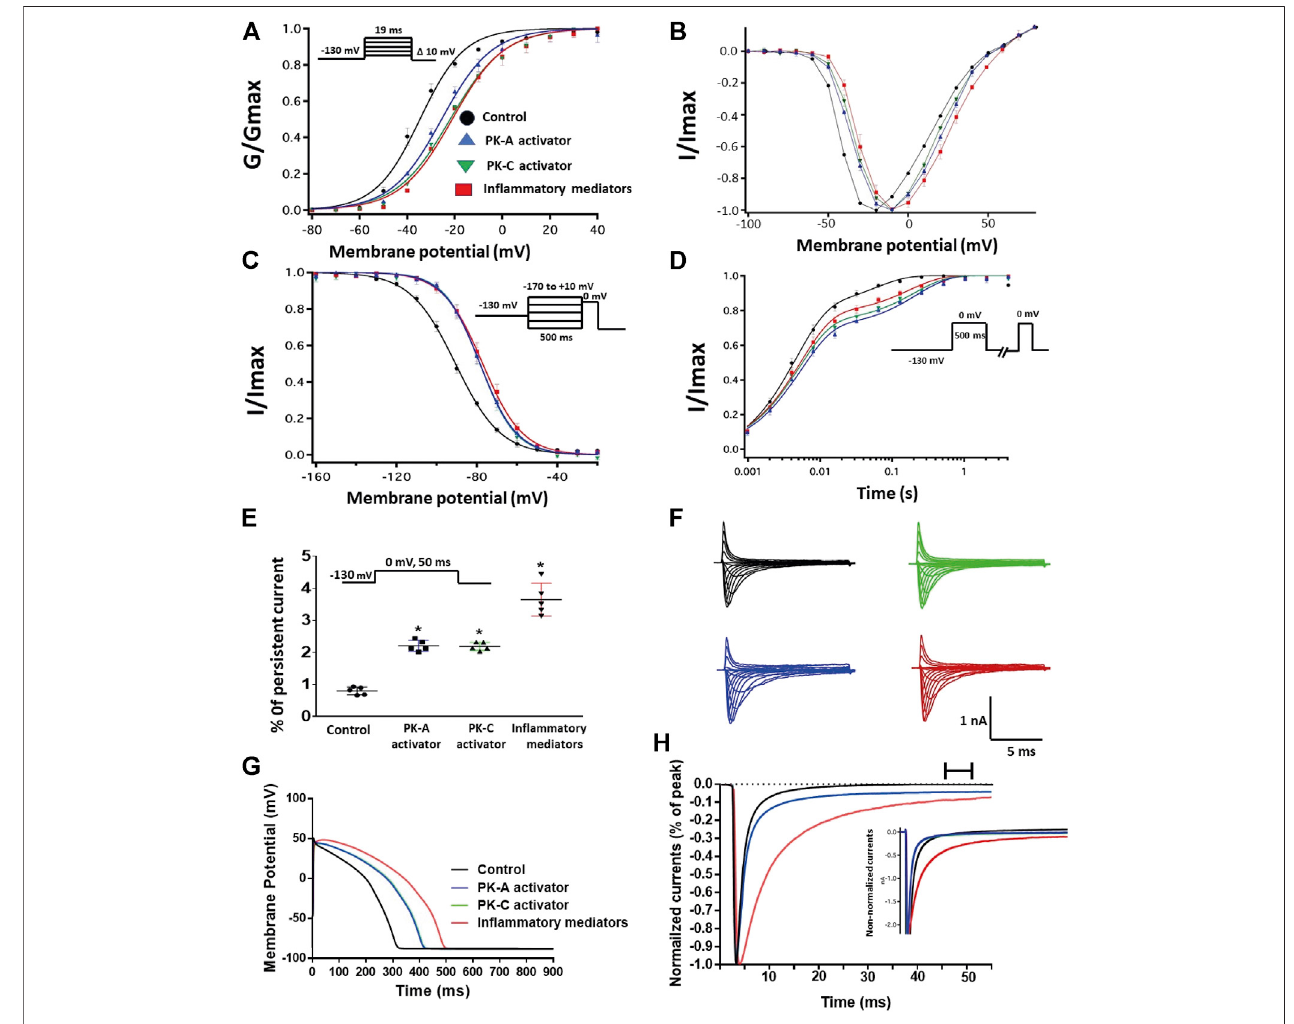
FIGURE 2 | (A) Effect of in fl ammatory mediators (for 24 h) or PK-A activator (CPT-cAMP; 1 μ M, for 20 min) or PK-C activator (PMA; 10 nM, for 20 min) on conductance curve Nav1.5transfectedCHO cellswith theinsert showing the protocol (n (cid:2) 5,each). (B) IV curves (C) Effect ofin fl ammatory mediators (for 24 h)or PK-A activator (CPT-cAMP; 1 μ M,for20 min)orPK-Cactivator (PMA; 10 nM,for20 min)on SSFIofNav1.5transfectedCHO cellswiththeinsert showingthe protocol( n (cid:2) 5, each). (D) Effect ofin fl ammatorymediators(for 24 h)orPK-Aactivator (CPT-cAMP;1 μ M,for20 min)or PK-Cactivator (PMA; 10 nM,for20 min)onrecoveryfrom fastinactivationofNav1.5transfectedCHOcellswiththeinsertshowingtheprotocol( n (cid:2) 5,each). (E) Effectofin fl ammatorymediators(for24 h)orPK-Aactivator(CPT- cAMP; 1 μ M, for 20 min) or PK-C activator (PMA; 10 nM, for 20 min) on the percentage of persistent sodium currents of Nav1.5 transfected CHO cells with the insert showingtheprotocol( n (cid:2) 5,each). (F) Representativefamiliesofmacroscopiccurrents. (G) EffectofPK-Aactivator(CPT-cAMP;1 µMfor20 min),PK-Cactivator(PMA; 10 nM, for 20 min) or in fl ammatory mediators (for 24 h) on the In silico action potential duration of Nav1.5 transfected CHO cells. (H) Representative persistent currents across conditions. Currents were normalized to peak current amplitude. Bar above current traces indicates period during which persistent current was measured. Inset shows non-normalized currents. * p < 0.05 vs. corresponding “ Control ” values using one-way ANOVA along with post hoc testing.